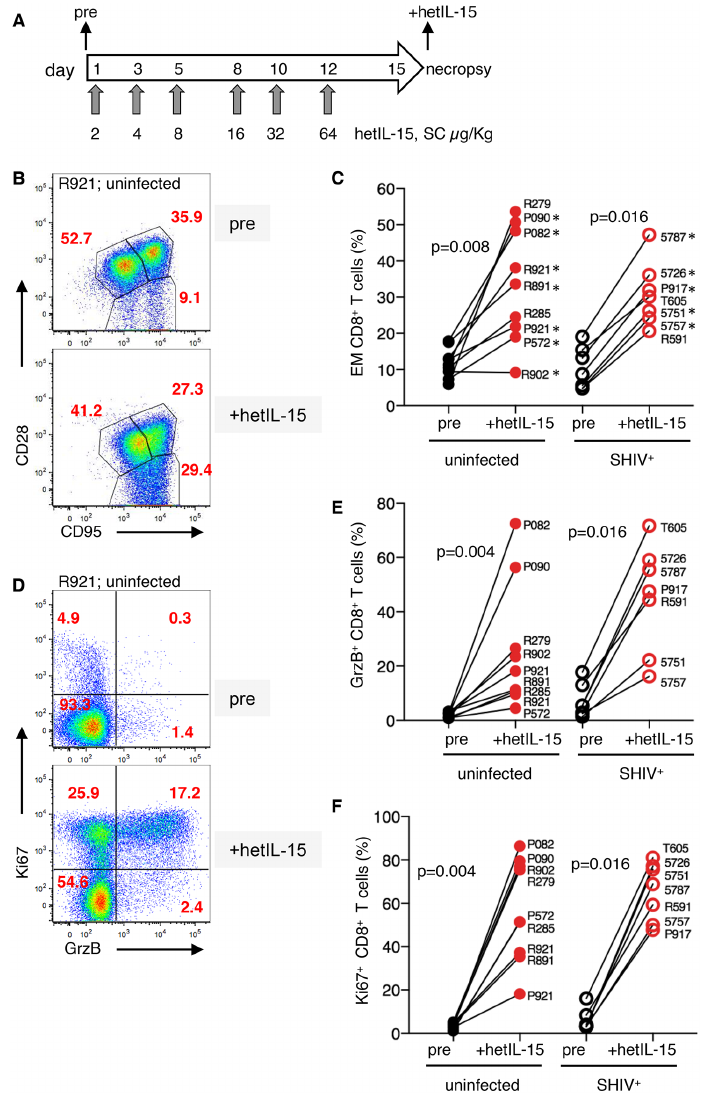
Fig 1. Lymphocyte changes in LN after hetIL-15 treatment. (A) Step-dose regimen of six SC hetIL-15 administrations in rhesus macaques. LN, blood and mucosal tissue lymphocytes were analyzed before (pre) and after treatment (+hetIL-15). Flow cytometry dot plots of LN mononuclear cells show (B) the frequency of CD8 + memory subsets, naïve (T N , CD28 + CD95 low ), central memory (T CM , CD28 high CD95 + ) and effector memory (T EM , CD28 - CD95 + ), and (D) granzyme B content and cycling status (GrzB + Ki67 + ) from a representative uninfected macaque (R921) upon hetIL-15 treatment. Graphs (C, E, F) summarize results of 16 macaques treated with hetIL-15 of (C) frequency of effector memory CD8 + T cells, (E) CD8 + GrzB + T cells, and (F) cycling (Ki67+) CD8 + T cells. Analysis was performed on LN of 9 uninfected animals (filled symbols) and 7 SHIV + macaques (open symbols). Black symbols, pre; red symbols, +hetIL-15. P values are from paired Wilcoxon signed rank test. The 12 animals that were also analyzed for hetIL-15 effects in blood and mucosal tissues (Figs 2 and 3) are indicated by (cid:3) .